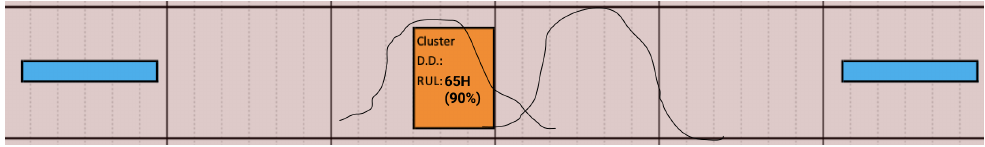
Figure 6. The participant proposed visualizing two RUL, showing how it could be represented by roughly drawing the two overlap thin black